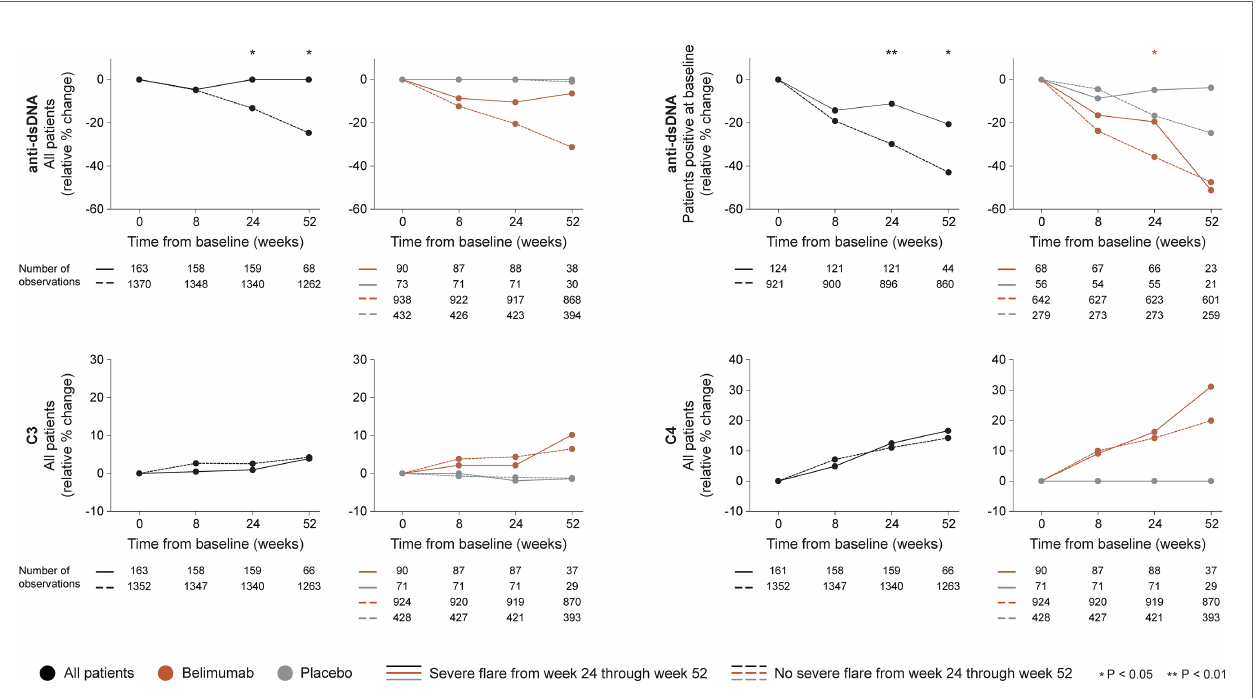
FIGURE 4 | Changes in serological markers in relation to severe fl ares occurring from week 24 through week 52. The graphs delineate relative to baseline percentage changes in anti-dsDNA, C3 and C4 levels from baseline through different time points in patients who developed at least one severe SFI fl are from week 24 through week 52 (continuous lines) and patients who did not (dashed lines). Comparisons between patients who fl ared and patients who did not were conducted for the entire population with available data (black lines), and after strati fi cation into patients who received standard therapy plus belimumab (terracotta lines) and patients who received standard therapy alone (grey lines). For anti-dsDNA levels, a separate analysis for patients with positive anti-dsDNA levels ( ≥ 30 IU/mL) at baseline is also demonstrated. P values derived from non-parametric Mann-Whitney U tests. The number of patients with available data at each time point is indicated for each patient subgroup. SFI, Safety of Estrogens in Lupus Erythematosus National Assessment (SELENA) - Systemic Lupus Erythematosus Disease Activity Index (SLEDAI) Flare Index; anti-dsDNA, anti-double stranded DNA antibodies; C3, complement component 3; C4, complement component